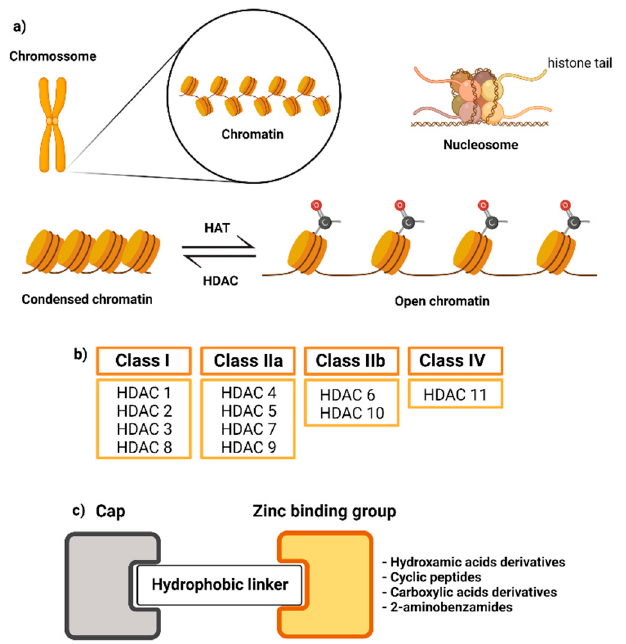
Figure 1. Summary of the mechanism of action of HATs and HDACs, classifications of HDACs, and the scaffold of an HDAC inhibitor (created by using BioRender.com); ( a ) Mechanism of action of HAT and HDAC; ( b ) Classification of HDACs; ( c ) Scaffold of HDAC inhibitor